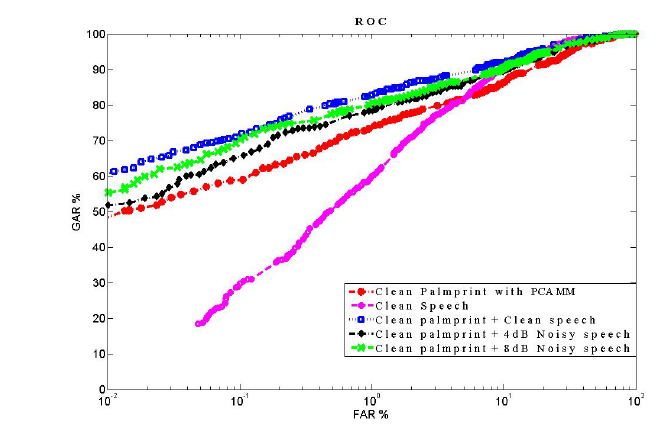
Figure 9. ROC curves for match score level fusion of clean palmprint using PCA MM with speech (both clean and